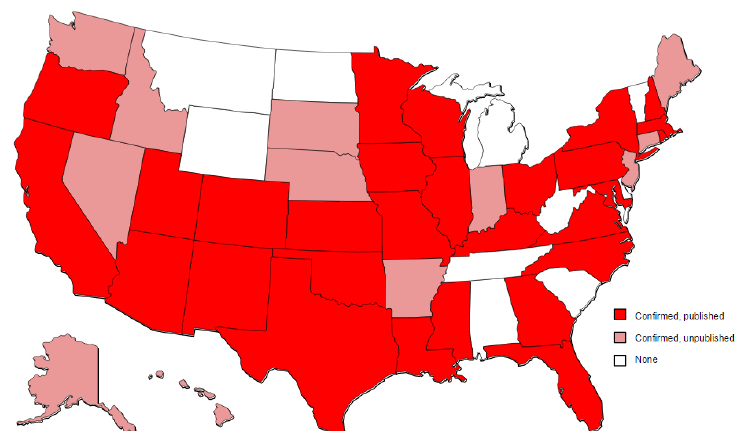
Figure 1. Pediatric Nickel Allergic Dermatitis - Map D of Interactive Poster Session